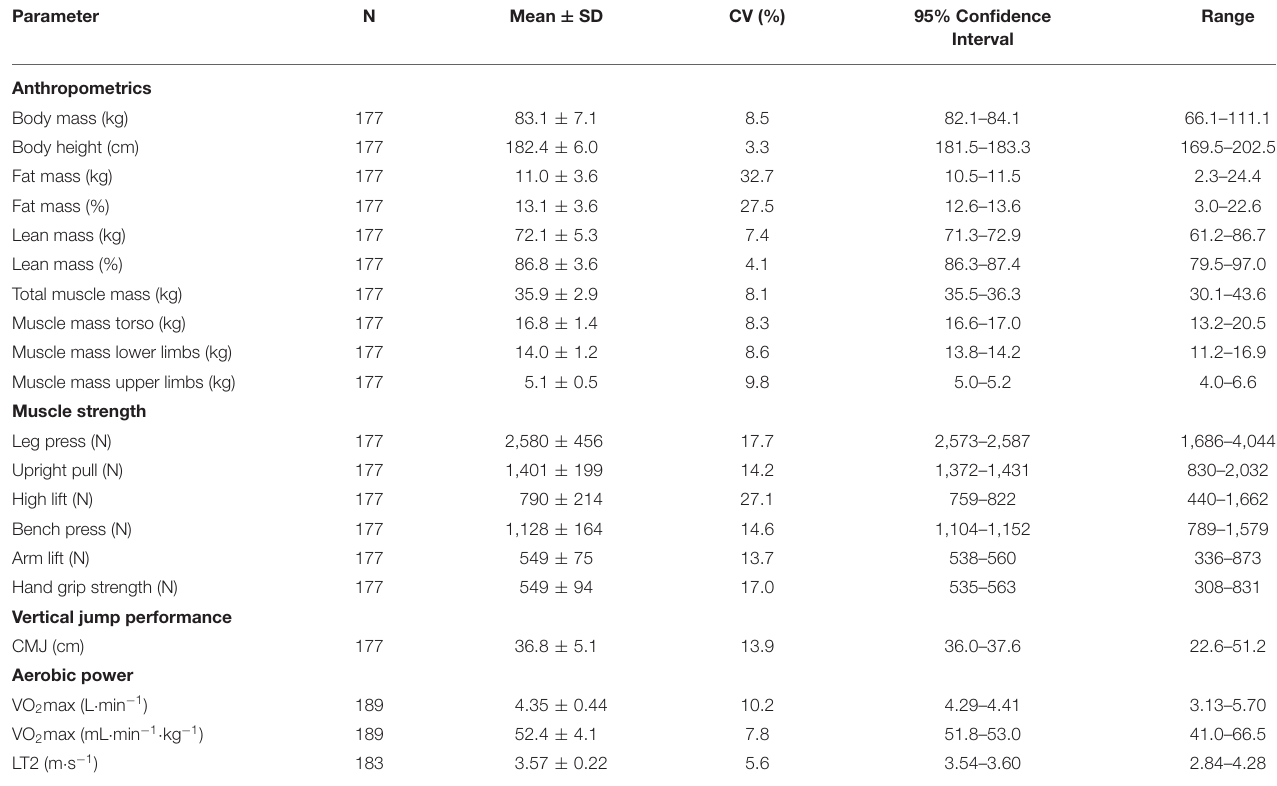
TABLE 1 | Anthropometric and performance test results of German special operations police